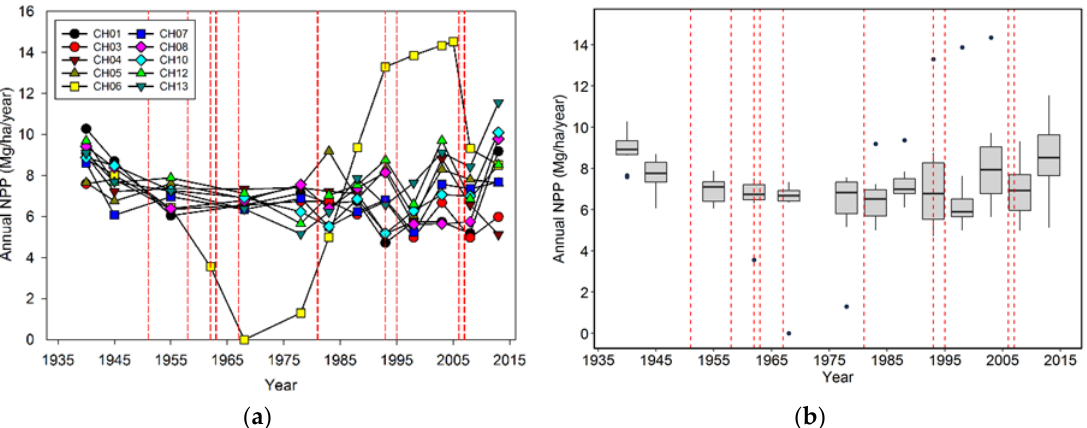
Figure 12. Net primary productivity (NPP) of boles (Mg/ha/year) in each of the ten permanent plots ( a ) and median across ten permanent plots ( b ). The red vertical lines indicate major wind events.